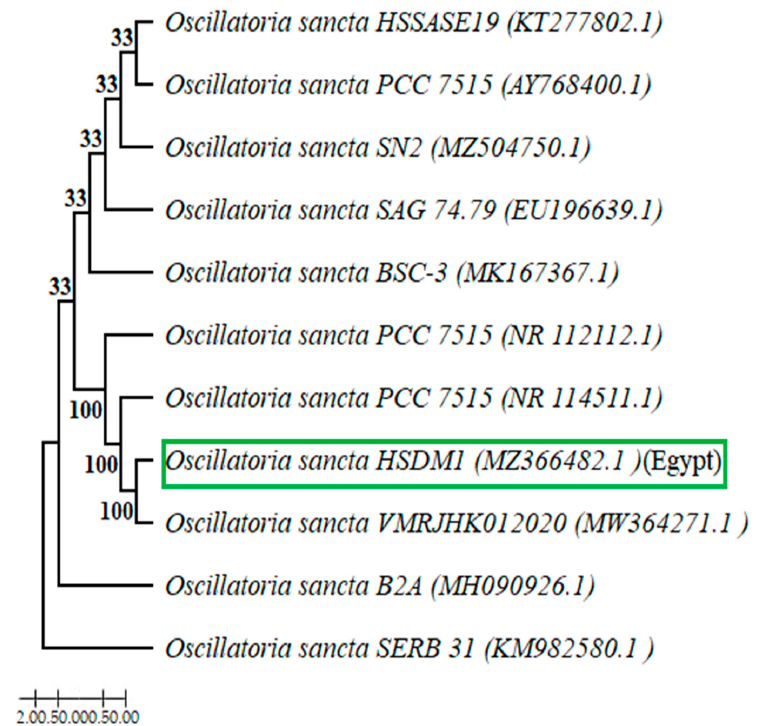
Figure 1. Phylogenetic tree dendrogram based on O. sancta 16S rRNA gene sequence using the bootstrap test of the maximum-likelihood (ML) technique.